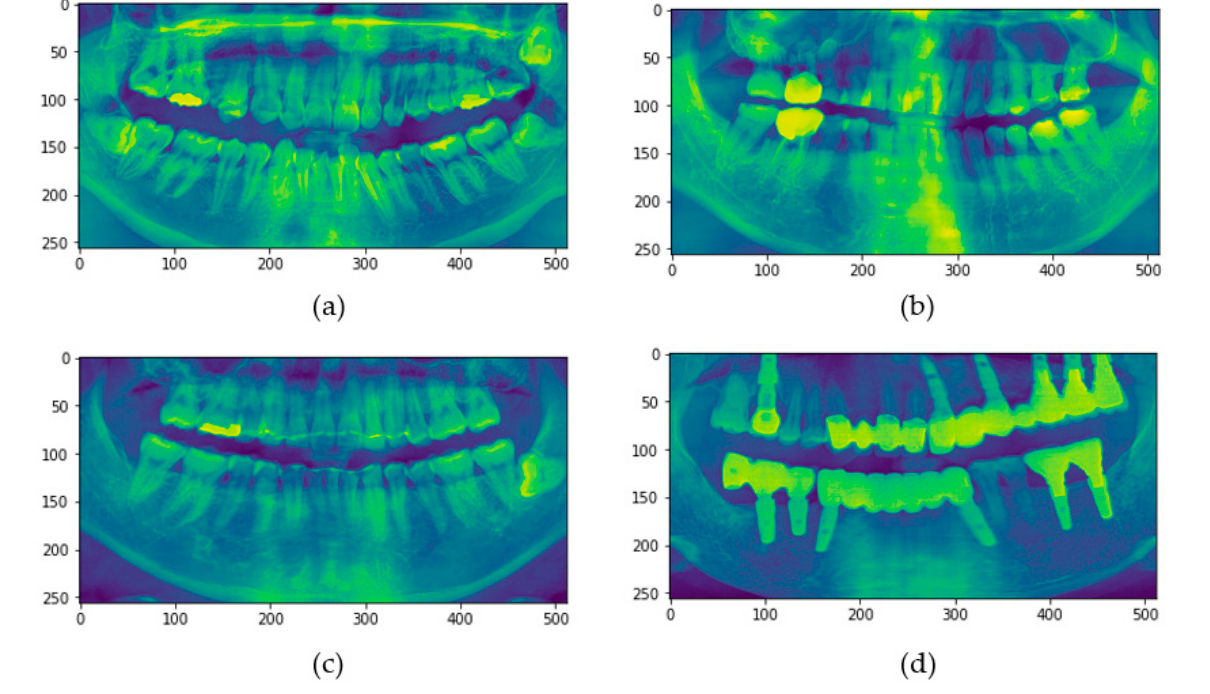
Figure 8. Dental radiographs of persons whose dental ages were successfully predicted using panoramic radiography to within ± 5 years: ( a ) actual age is in the 20s, predicted dental age is 24.41; ( b ) actual age is in the 60s, predicted dental age is 60.88; ( c ) actual age is in the 30s, predicted dental age is 32.67; and ( d ) actual age is in the 60s, predicted dental age is 61.85.